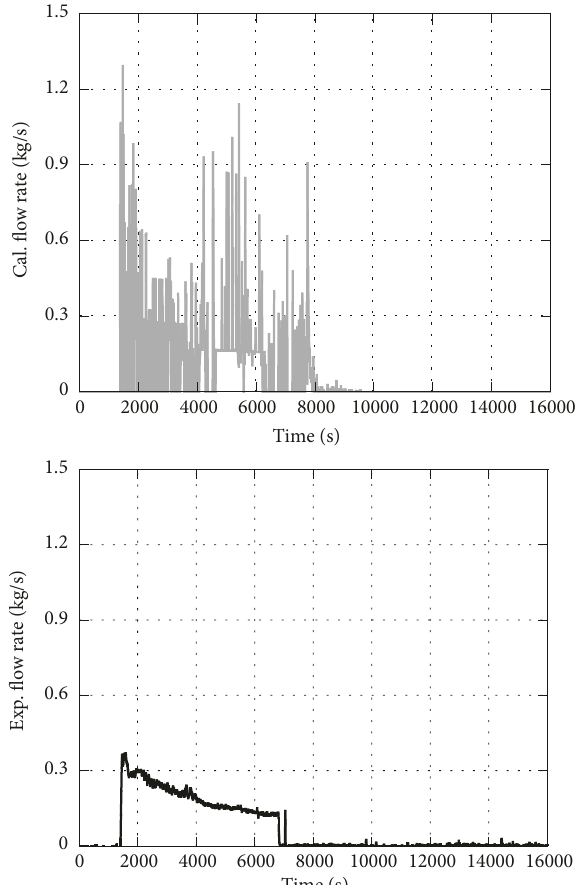
Figure 25: TR-LF-16 test and RELAP5 results for ACC flow rate in loop A.